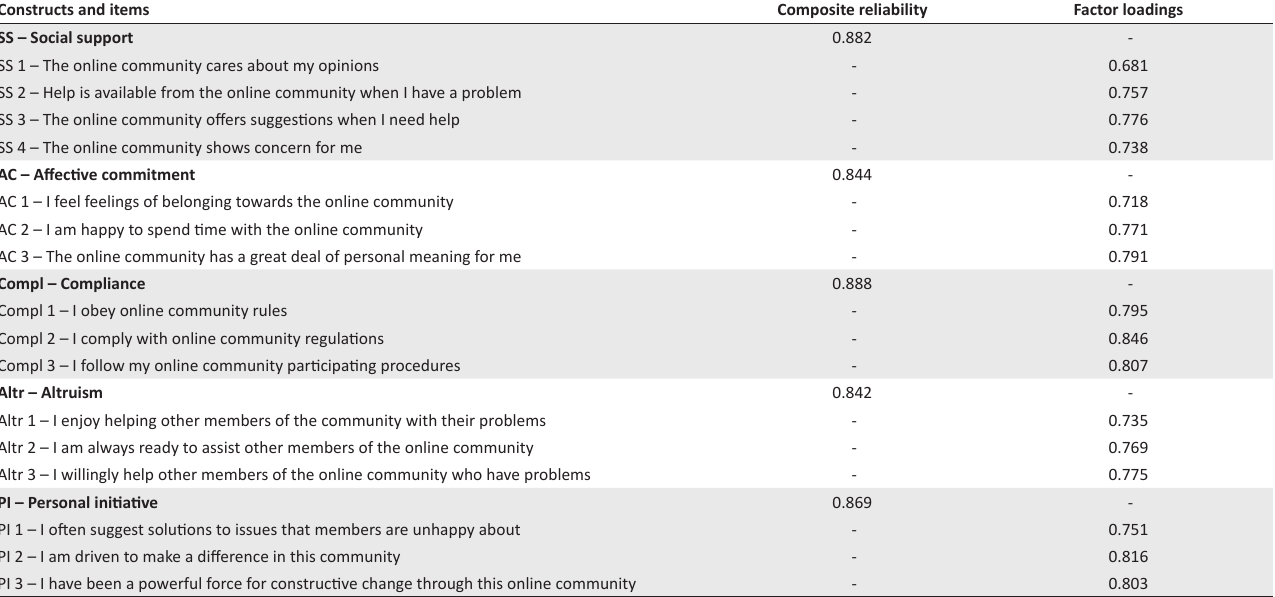
TABLE 1: Measurement items, reliability, and factor loadings. Constructs and items